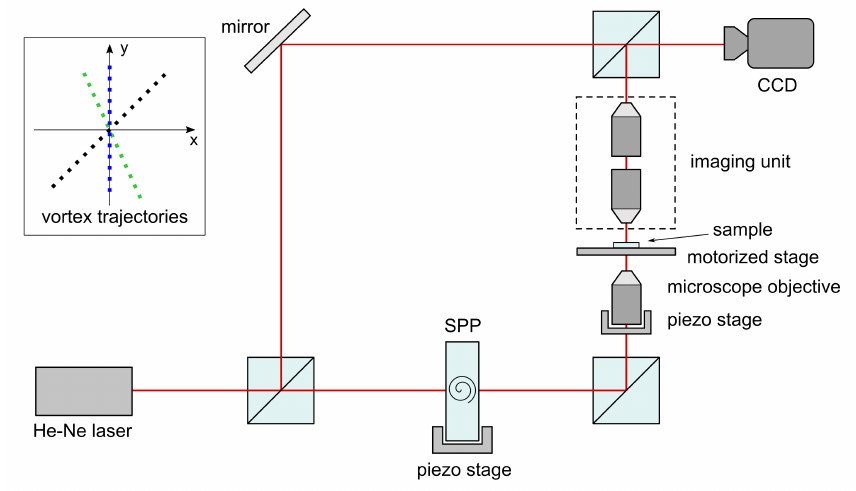
Figure 1. The scheme of optical vortex scanning microscope (OVSM). In the inset the registered three vortex trajectories are shown. The vortex trajectories are subsequent positions of vortex point (vortex point is a point where the phase is singular) at sample plane while moving the SPP perpendicularly to the optical beam. The three trajectories were measured at three slightly different positions of focusing objective. This objective was moved toward the